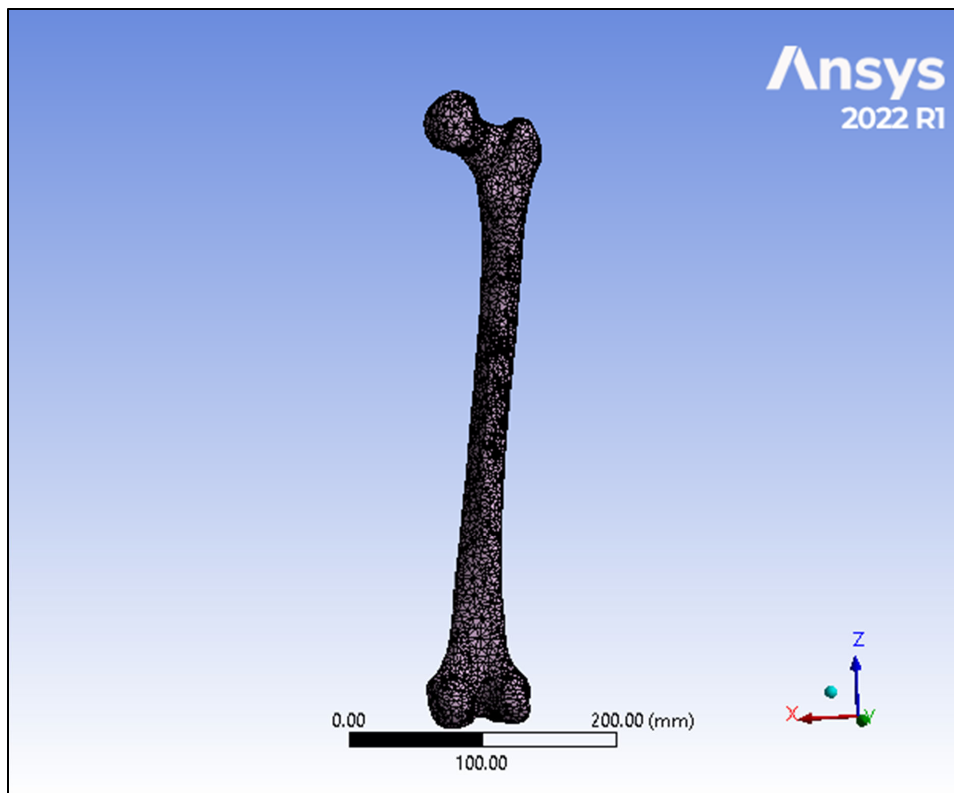
Figure 5. The 3D model of the femoral bone showing the meshing with 31,945 nodes and 17,856 elements.